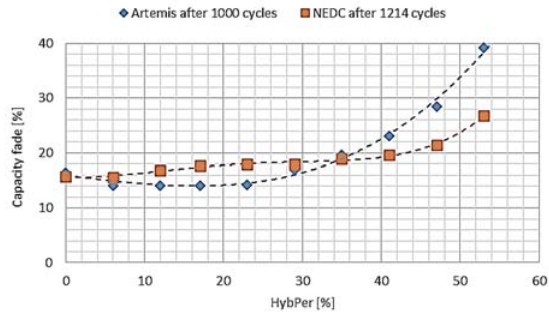
Figure 9. The battery aging for topology 2 as a function of the hybridization percentage for two different driving cycles.